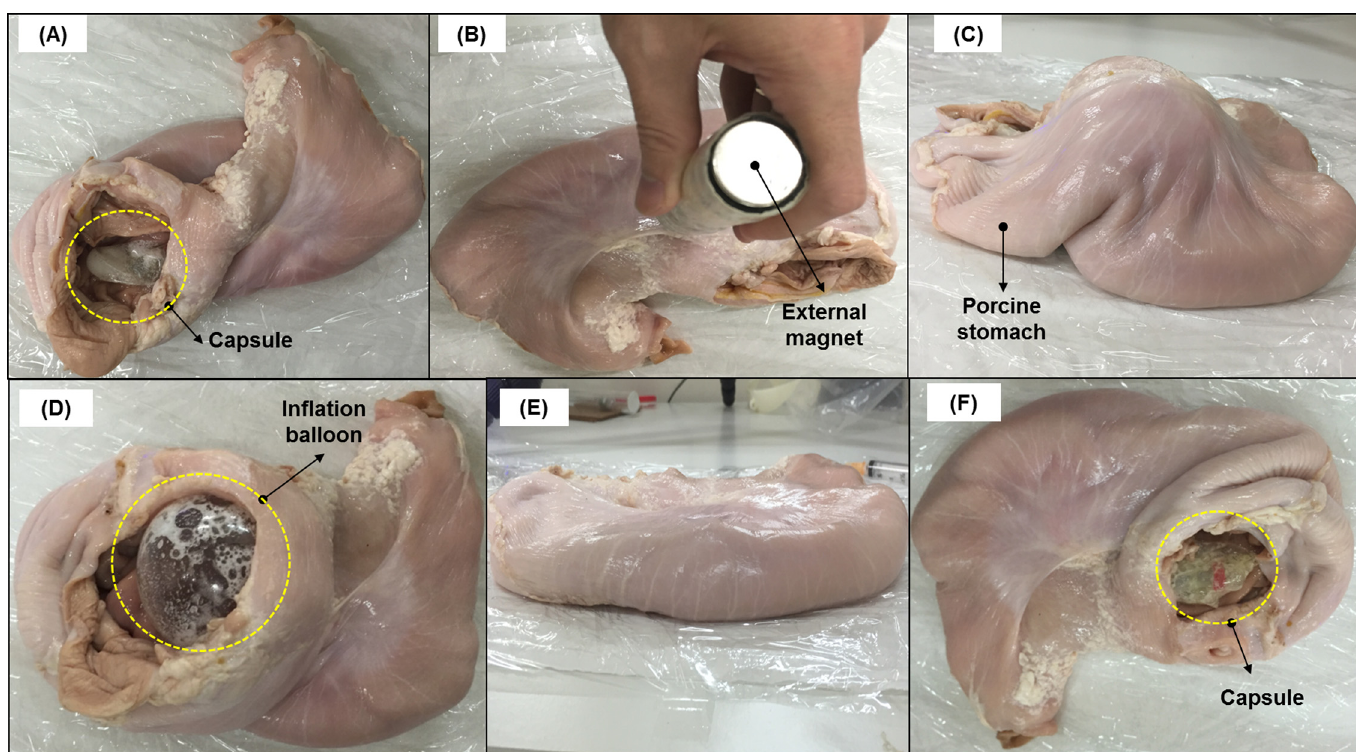
Fig 12. Validation results for the proposed MWCE on a porcine stomach. (A) Inserting the capsule-balloon into a porcine stomach. (B) The external magnet approaches the porcine stomach to inflate the balloon. (C) The balloon is inflated inside the porcine stomach after 15 minutes of the reaction. (D) The inflation balloon is partially exposed on the porcine stomach. (E) The balloon is deflated to its original compact size. (F) The deflation balloon and its inner capsule are partially exposed on the porcine